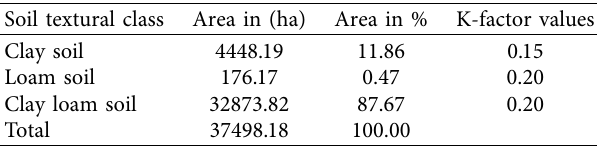
Table 2: Soil textural class, area coverage, and their erodibility